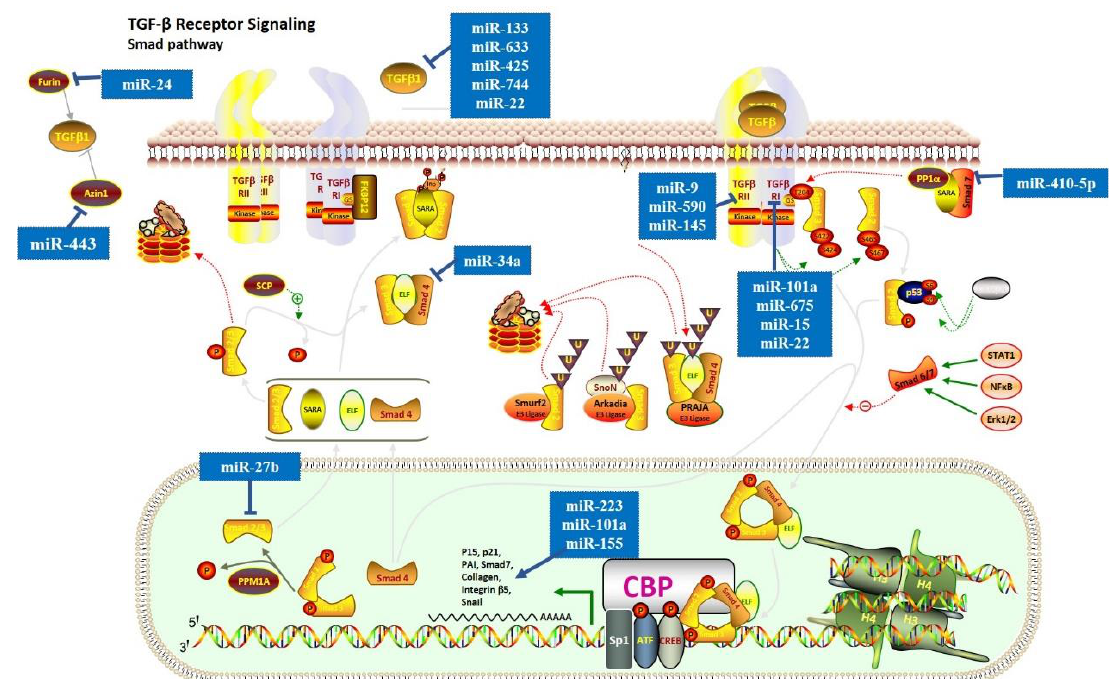
Figure 2. MiRNAs in the regulation of Smad-dependent (canonical) signaling pathway. In the canonical TGF- β signaling pathway, TGF- β 1 interacts with TGFβRI/TGFβRII, leading to the phos- phorylation of Smad2/3. This figure shows miRNAs that regulate the expression of the Smad-de- pendent (canonical) signaling pathway. The symbol of “——>” means positive effect, and the sym- bol of “——|” means n egative effect.